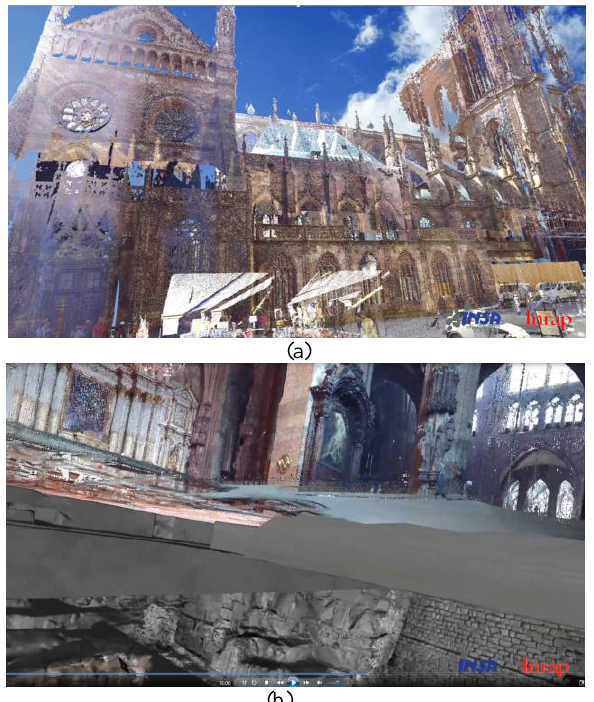
Figure 13. Screenshots of a video animation dedicated to general public: a) first sequence out of the cathedral; b) sequence prior to entering the basement area.